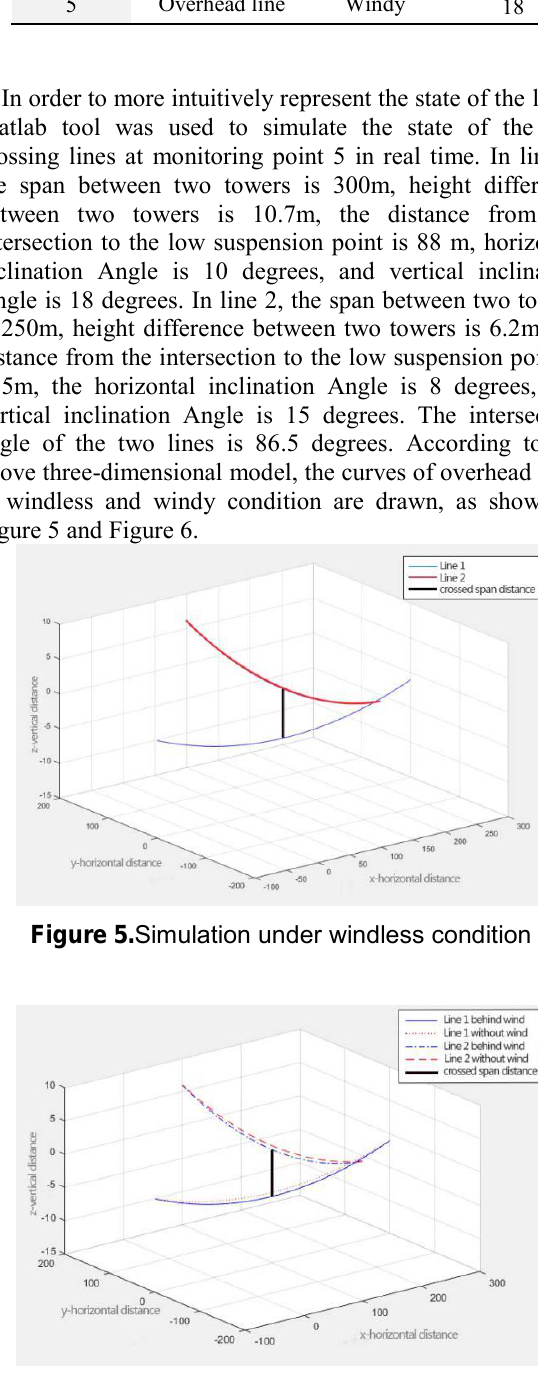
Figure 6. Simulation under wind condition The dynamic change of lines can be seen intuitively through the graph. According to the span, height difference, the distance from the intersection to the low